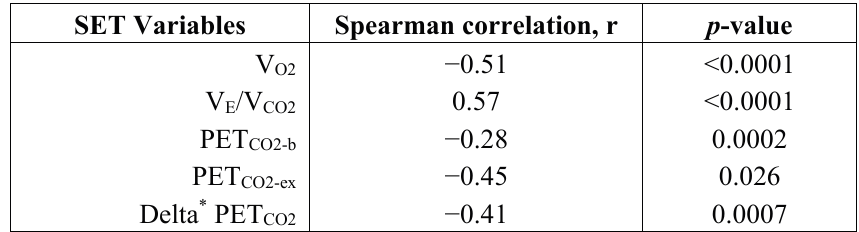
Table 2. Correlation between submaximal exercise test (SET) parameters and the REVEAL registry risk score (RRRS).